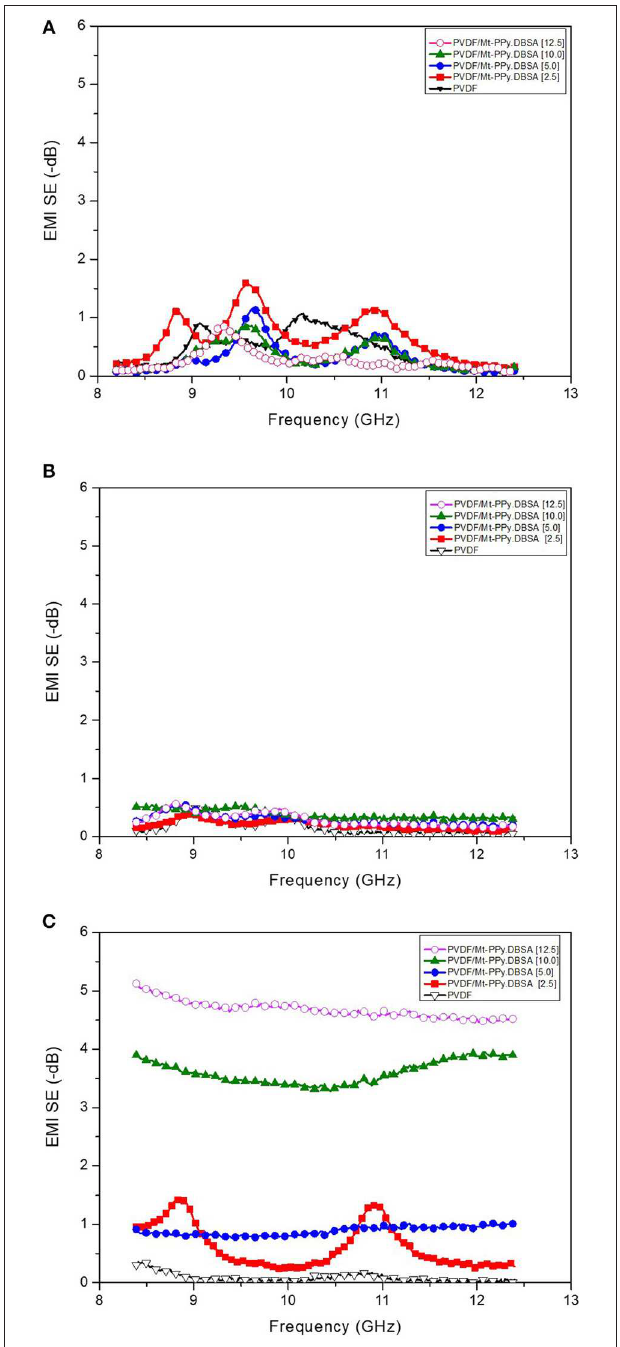
FIGURE 7 | EMI SE in the X-band frequency range for (A) electrospun mats of PVDF/Mt-PPy.DBSA and (B,C) membranes of PVDF/Mt-PPy.DBSA fabricated by solution casting process with thickness of 0.15mm and 0.25mm,